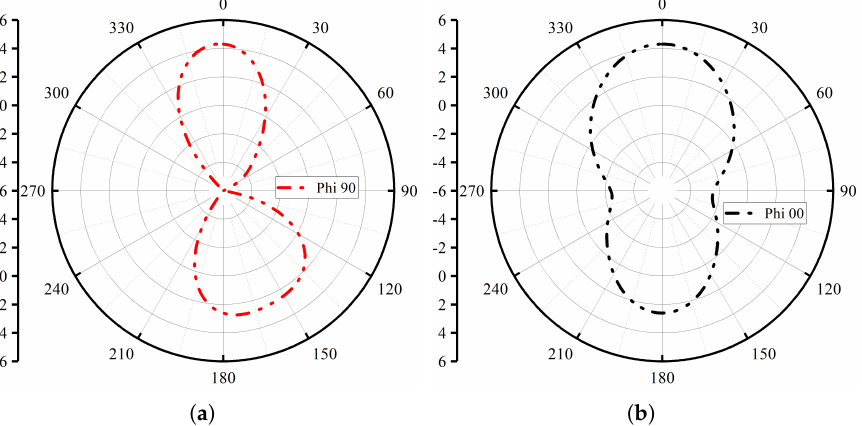
Figure 6. Radiation patterns at 28 GHz frequency on plane ( a ) zy and ( b ) zx